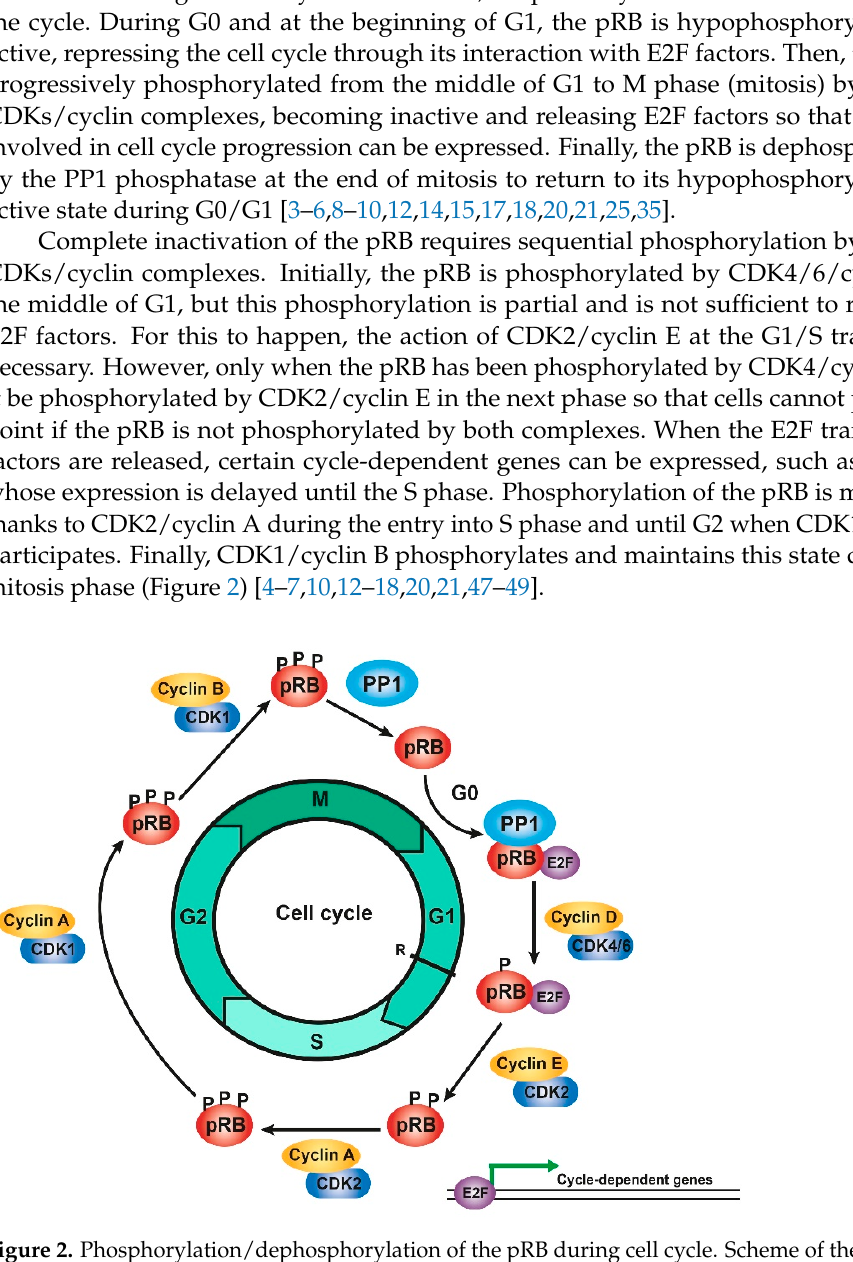
Figure 2. Phosphorylation/dephosphorylation of the pRB during cell cycle. Scheme of the regulation of the phosphorylation status of the pRB by different CDKs/cyclin and by PP1 during the different cell cycle phases. Figure adapted from [4,11,21].